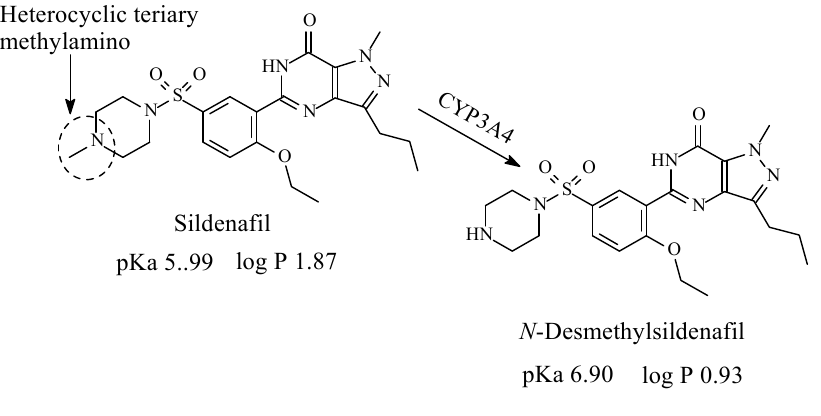
Figure 37. Metabolism of